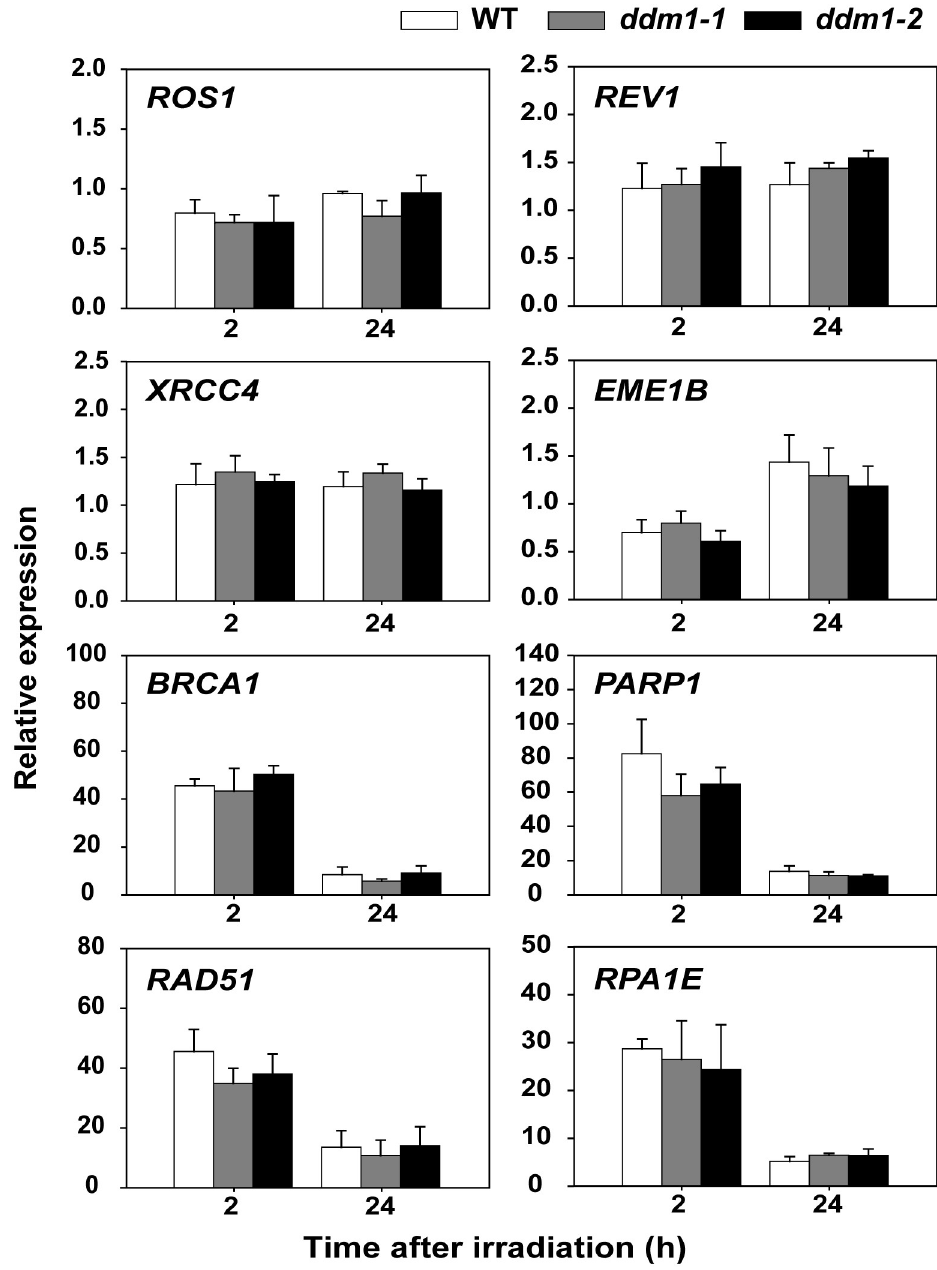
Fig 3. Radiation-sensitive phenotypes of ddm1 mutants are not due to the altered transcription of DDR genes. Quantitative real-time PCR analysis of the expression of DDR genes in WT and ddm1 mutants 2 and 24 h after gamma irradiation. BRCA1 , breast cancer 1; RPA1E , replication protein A 1e; PARP1 , poly [ADP-ribose] polymerase 1; RAD51 , radiation sensitive 51. Bars represent means ± SE (n = 3) of three independent experiments. ACTIN2 was used as an endogenous control